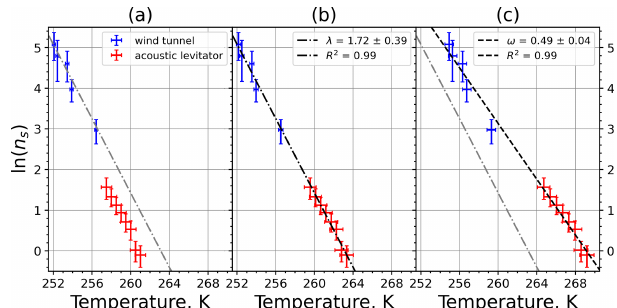
Figure 9. (a) Composite INAS density spectrum of kaolinite from the uncorrected M-WT (blue) and M-AL (red) measurements. Pan- els (b) and (c) show the temperature-corrected data points from the M-WT and M-AL experiments based on λ and ω , respectively. The dash-dotted line in (c) is the regression line for the corrected data points obtained by employing the optimal λ value as in (b) .